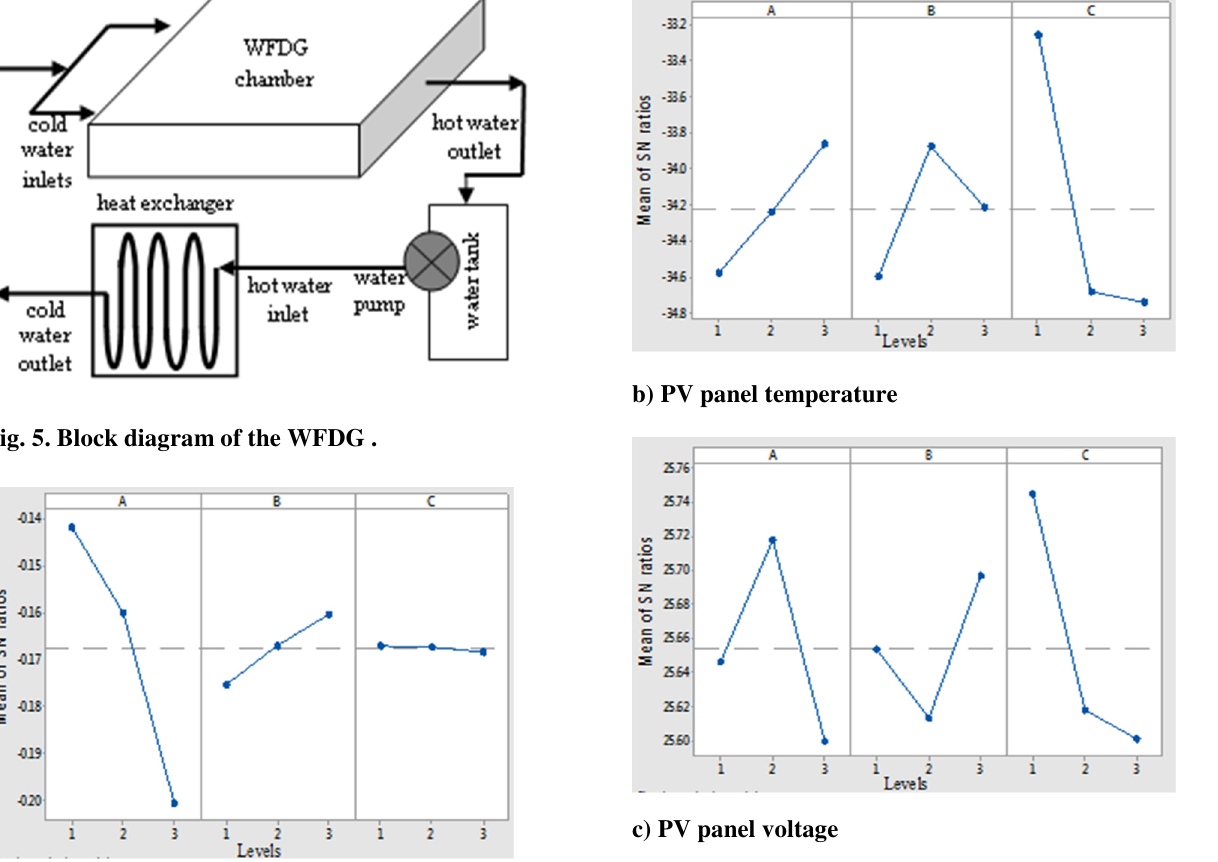
Fig. 6. The mean S/N ratios with levels for various responses.